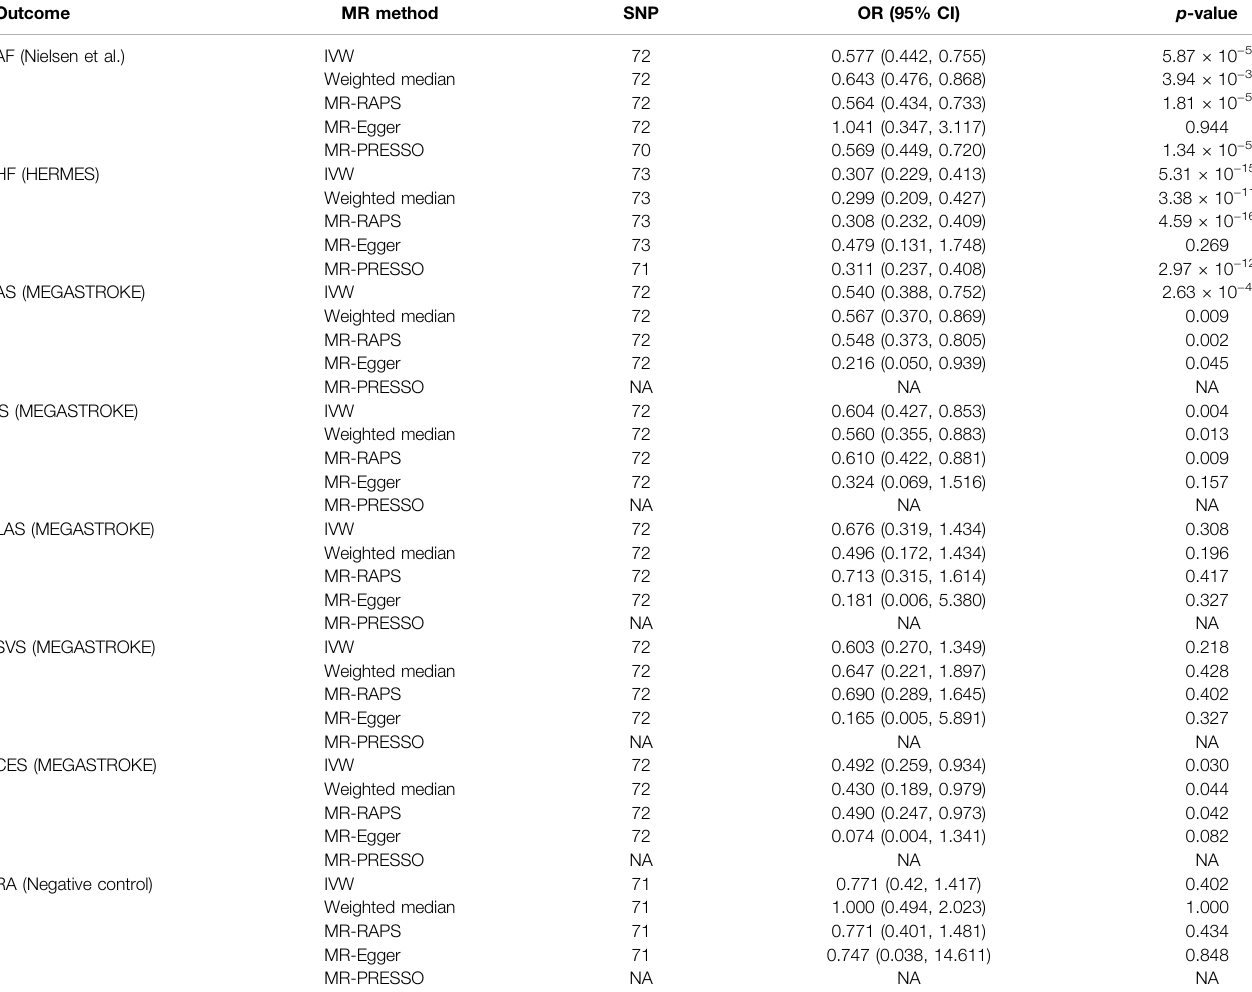
TABLE 2 | Sensitivity analyses of the associations of genetically predicted self-reported walking pace with cardiovascular diseases. Outcome MR method SNP AF (Nielsen et